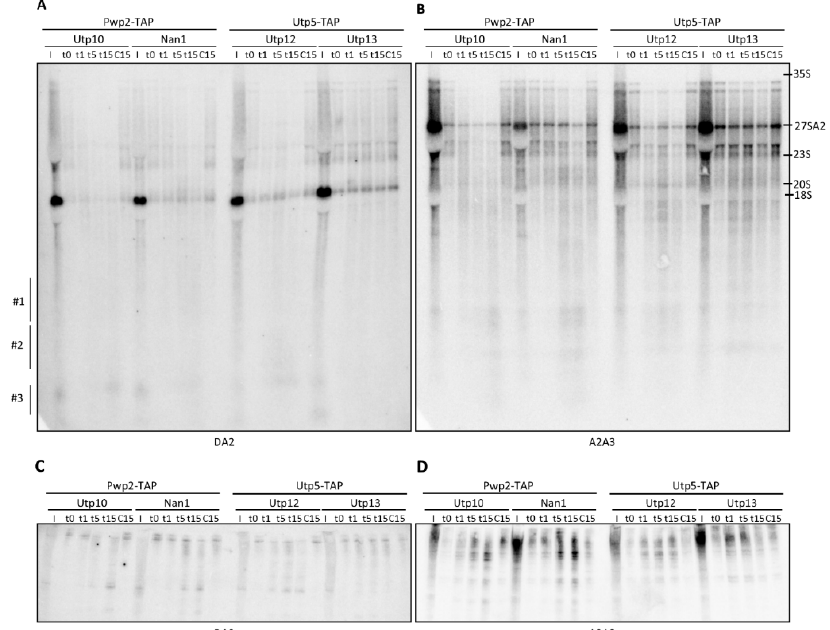
Figure 4. Structural probing of rRNA with tethered MNase analyzed by northern blot at the ITS1 region. Pwp2-TAP (for Utp10-MNase and Nan1-MNase) or Utp5-TAP (for Utp12-MNase and Utp13-MNase) containing pre-ribosomal particles were bound to IgG-Sepharose beads. After purification, MNase was activated by the addition of CaCl 2 , and samples were incubated at 16°C during a time course. At indicated time points, the reaction was stopped. RNAs were obtained by hot-phenol extraction, resolved in either formaldehyde-agarose gels ( A , B ) or acrylamide gels ( C , D ), and transferred to membrane for northern blot analysis. Components of the UTP complexes fused to TAP or MNase are indicated on top, and probes used for the detection of RNAs in the northern blot are indicated below the panels. The localization of some prominent rRNAs is indicated on the right side. The three different regions (#1 to #3) to describe the observed RNA fragments in Figure 2 are also depicted for better comparison of the results.